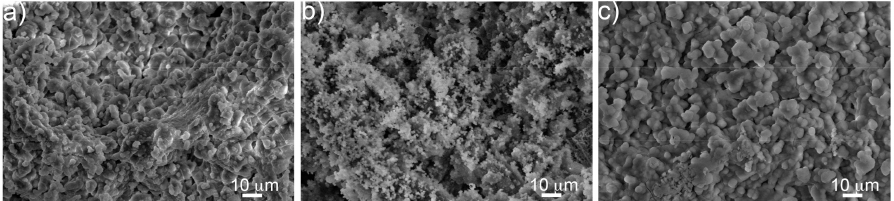
Figure 8. SEM micrographs of the unaged sample ( a ) and foams aged 2 ( b ) and 4 ( c ) weeks after 7 d of immersion in SBF.